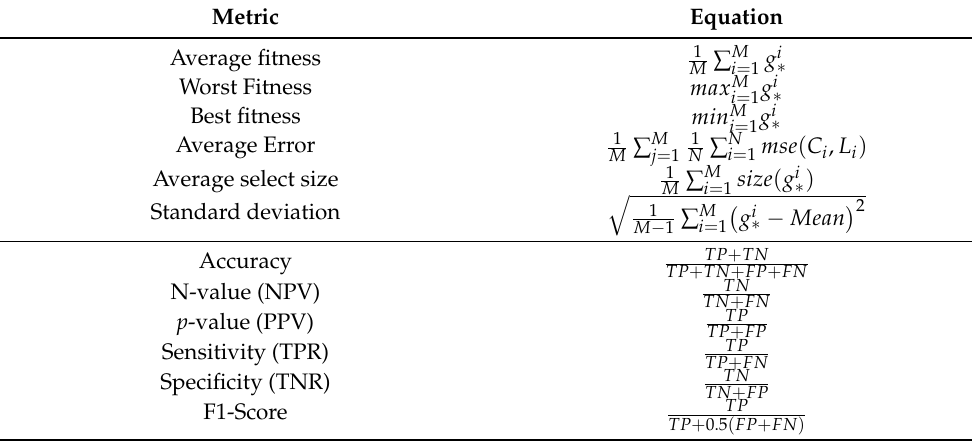
Table 2. Metrics used in evaluating the proposed algorithms.